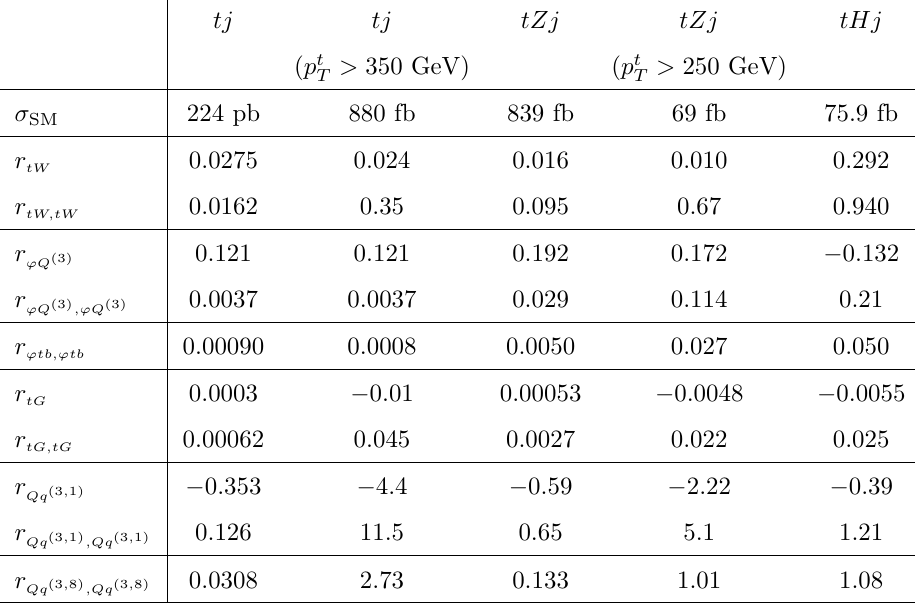
> 350 GeV), tZj T = (cid:27) (when non-zero) and the i i =(cid:27) SM and (cid:27) are de(cid:12)ned in eq. i i;i